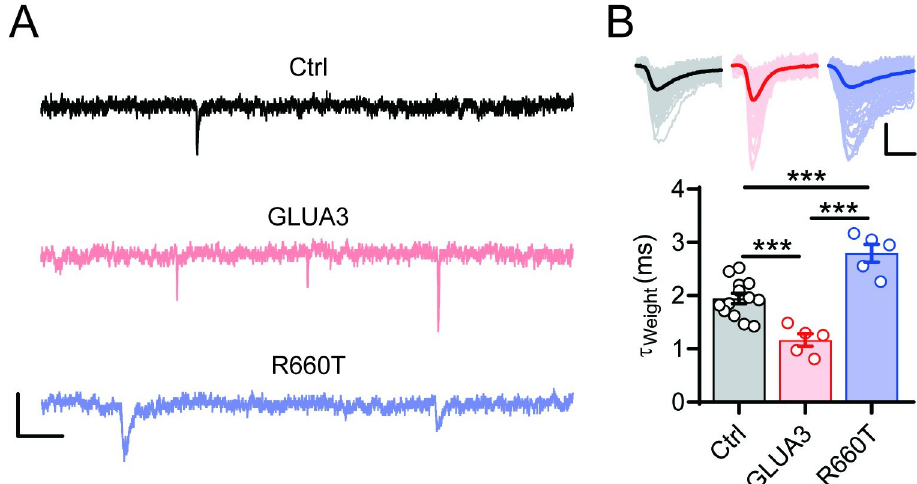
Fig 5. GLUA3_R660T slows mEPSC decay in CGNs. (A) Sample mEPSC recordings of untransfected (black), GLUA3-transfected (pink) and GLUA3_R660T-transfected (purple) CGNs. Scale bars, 10 pA and 50 ms. (B) The upper traces are superimposed individual mEPSC traces (light) recorded from signle neurons and the average traces (dark). Scale bars, 10 pA and 2 ms. The lower bar graph presents weighted decay tau of mEPSCs. Circles are the values calculated from average traces of individual neurons. Ctrl, 1.9 ± 0.1 ms, n = 13. GLUA3, 1.2 ± 0.1 ms, n = 5. R660T, 2.8 ± 0.2 ms, n = 5. ��� p < 0.001. One-way ANOVA.